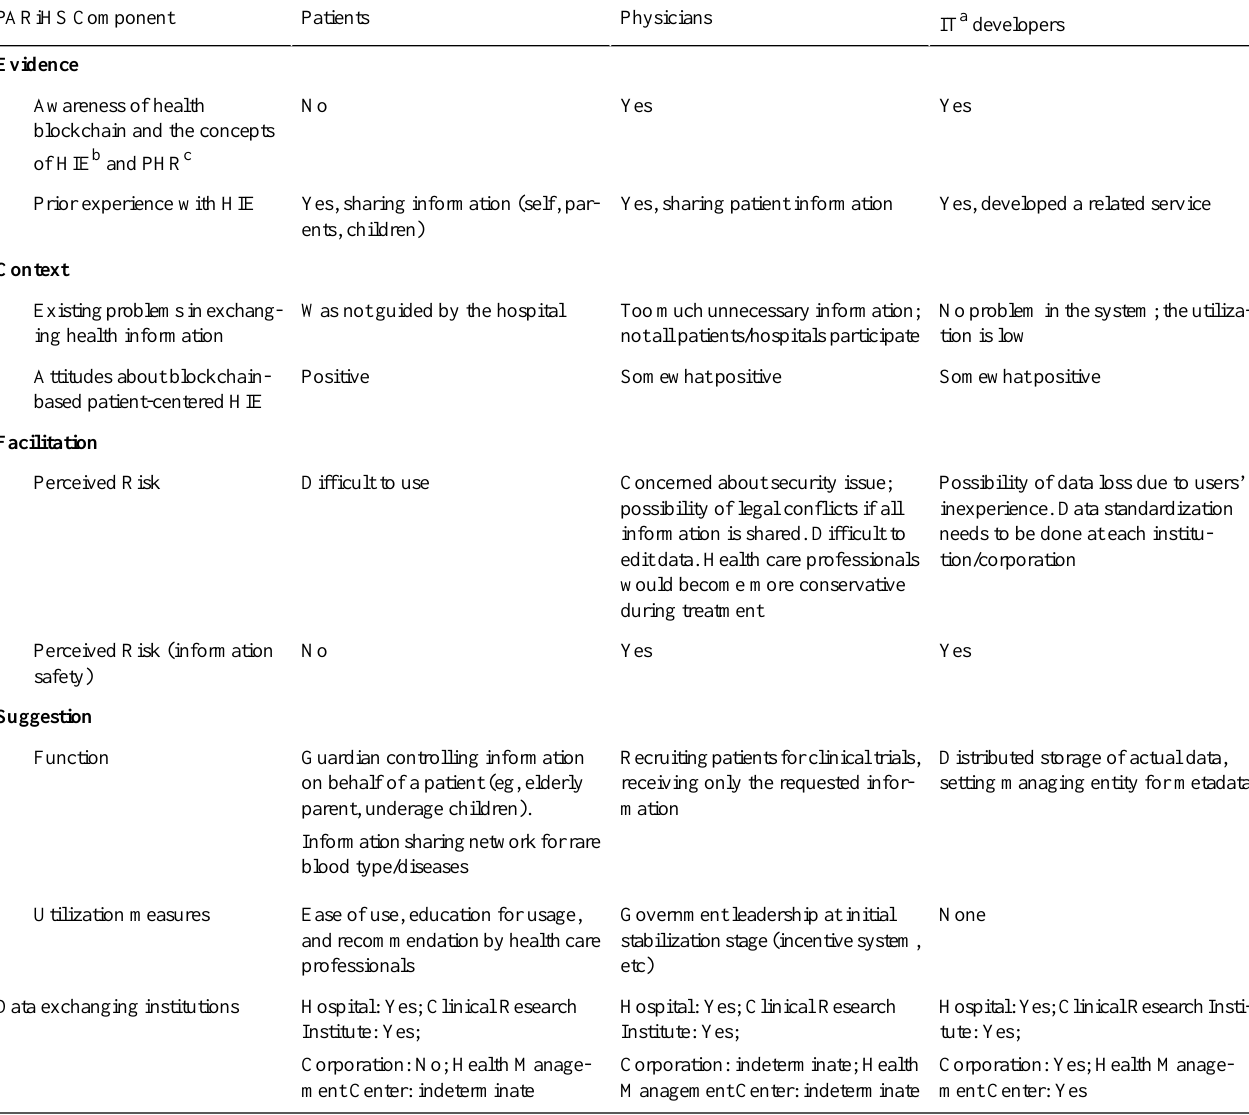
Table 2. Summary of the interviews for each component of the Promoting Action on Research Implementation in the Health Service (PARiHS)